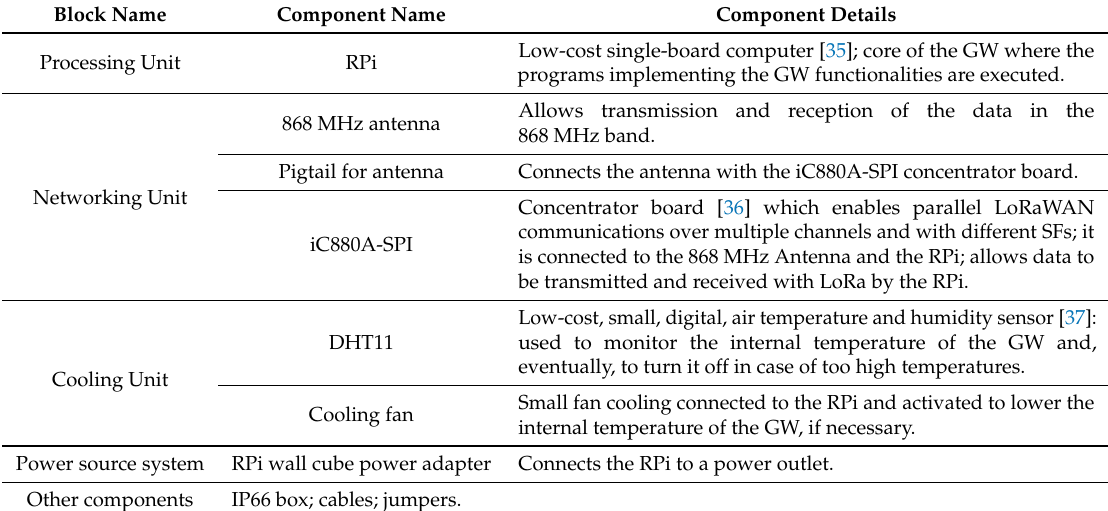
Table 1. The deployed LoRaWAN GW: selected hardware and components’